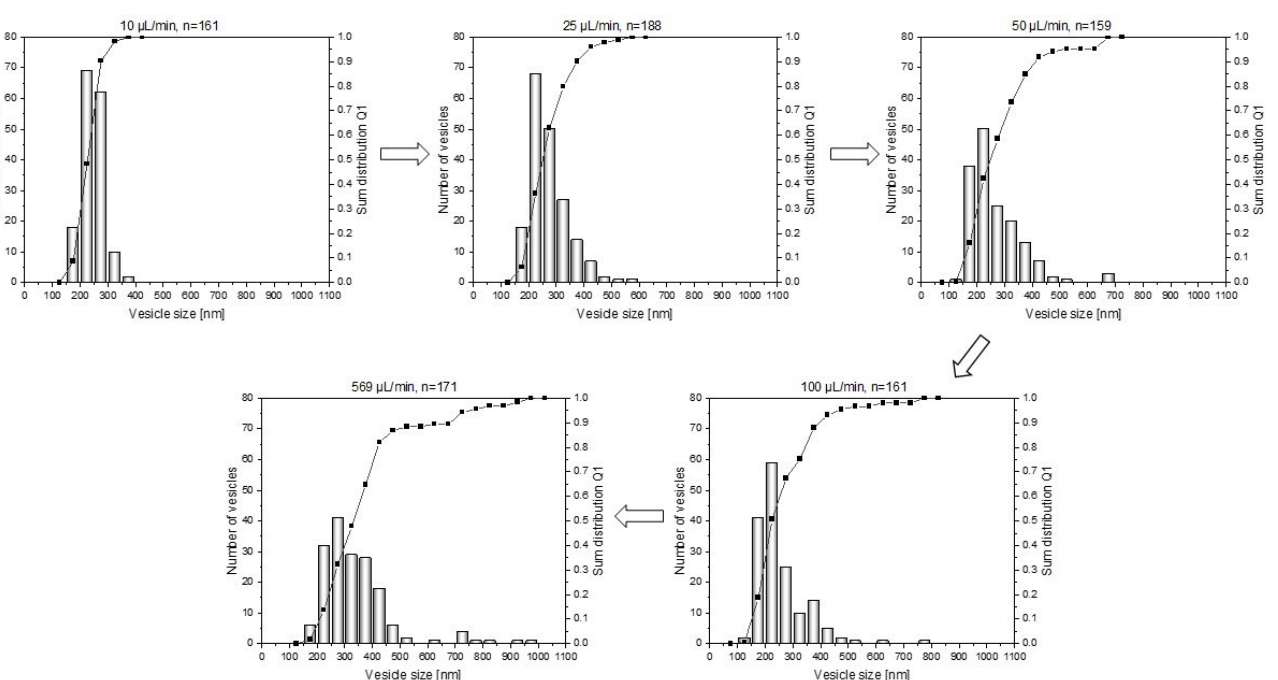
Table 2. Influence of the rate of water addition on the average vesicle size and polydispersity of the polymer vesicles.